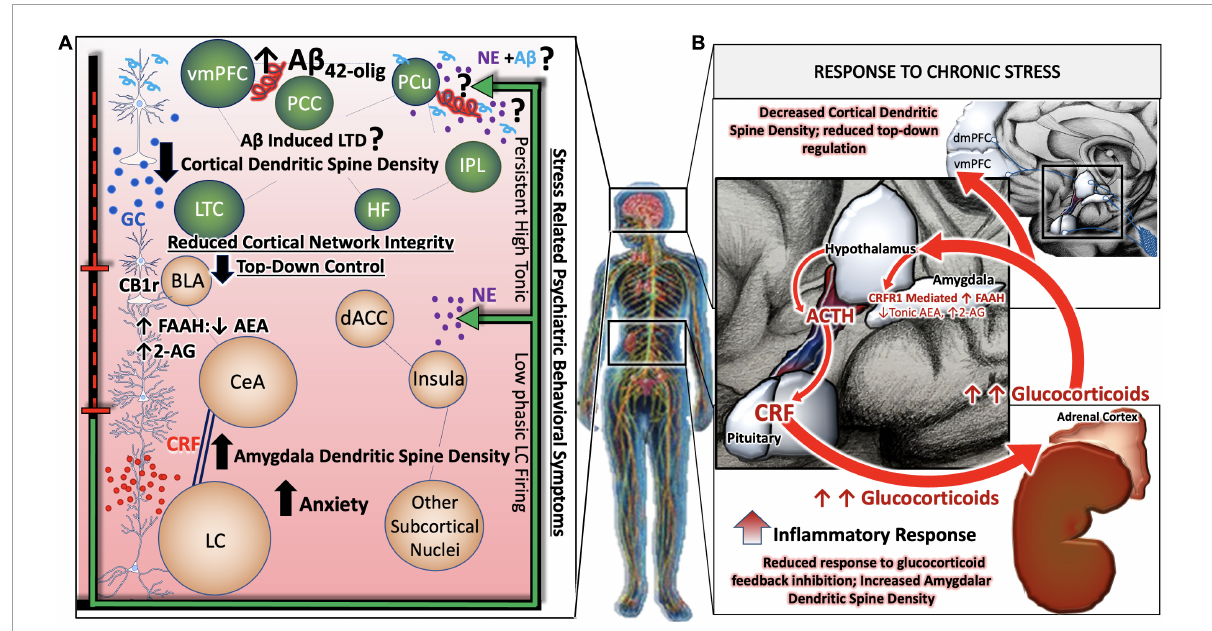
FIGURE2 Allostatic overload renders stress-responsive circuits vulnerable to neuronal injury and degeneration. During states of chronic or pathological stress, the HPA axis, LC, and associated stress integrative circuitry no longer respond to negative feedback inhibition, resulting in aberrant, unregulated, activity of the entire system (B) . Chronic stress related psychiatric behavioral symptoms are the result of complex, between- and within- network adaptations. While large-scale cortical networks become less intrinsically connected, and the microcircuitry that comprise them retract in dendritic density and complexity, there is correspondingly less top-down regulation of limbic circuitry. GABA-ergic interneurons of the BLA are disinhibited by decreased cortical input, leading to greater activity in limbic regions such as the central nucleus of the amygdala (CeA). Further shifts away from cortical control and toward limbic control occur as CeA afferents release increasing amounts of CRF in high frequency onto locus coeruleus (LC) neurons, rendering them more susceptible to stress-related excitotoxicity. A predominance of CB 1 r are found on cholecystokin (CCK)-positive GABAergic interneurons in the BLA. The inhibition of the BLA via CCK-positive GABAergic interneurons may be able to restore homeostatic LC tone by inhibiting CeA projections to the LC. In effect, this would silence HPA hyperactivation and halt the propagation of BLA excitability in a state of allostatic overload (A)